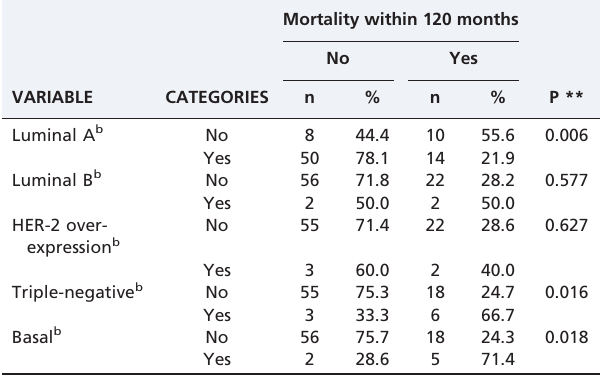
Table 3 - Case distribution according to biomolecular variables and mortality within 120 months of follow-up a among women with stage IIA tumors (n= 82).